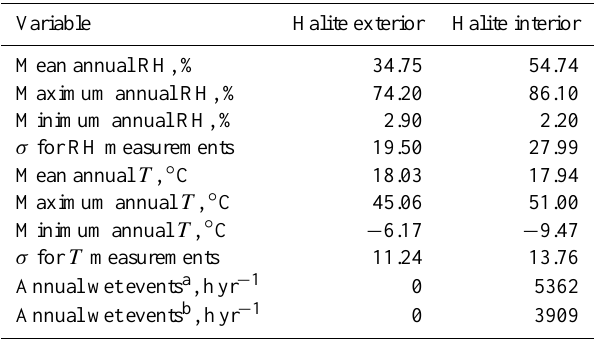
Table 2. Micro-environmental data measured simultaneously out- side and inside halite pinnacles in the Yungay